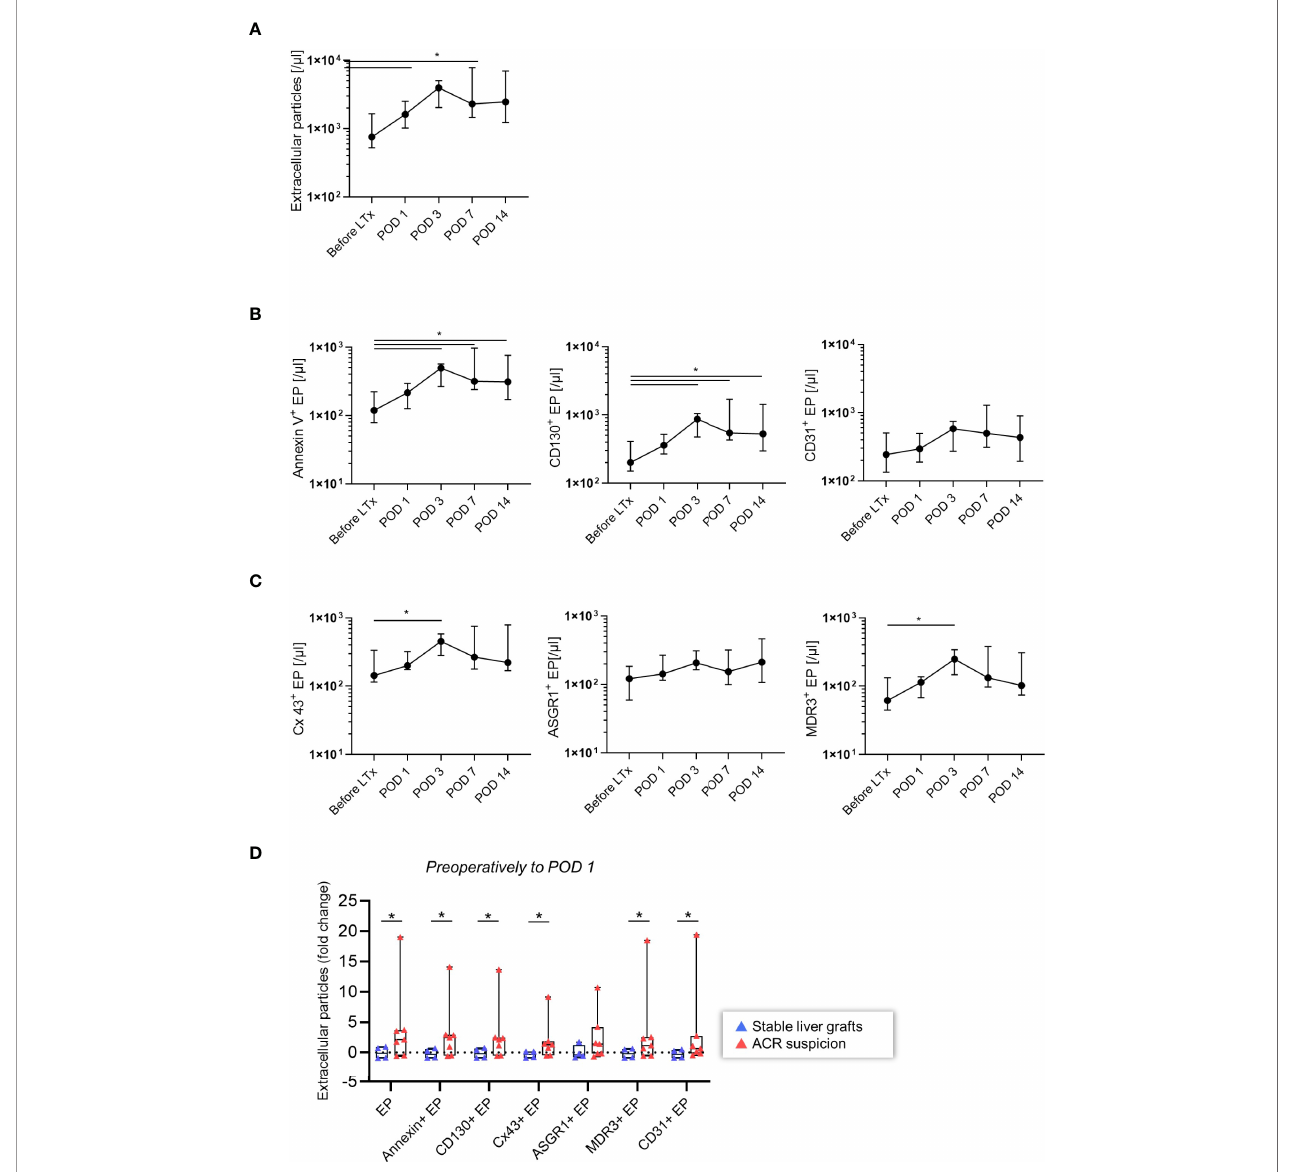
FIGURE 2 | Time course of EP after LT (n = 11). (A) Total EP (/µl) (B) AnnV + , CD130 + , CD31 + EP (/µl) (C) Cx43 + , ASGR1 + , MDR3 + EP (/µl) were stained and analyzed. The Wilcoxon matched-pairs signed ranked test was used. The plots are indicated by the median, and all error bars indicate the interquartile range (IQR). A single asterisk indicates signi fi cance at p < 0.05 (D) Patients at risk for acute rejection. EP dynamics from preoperative state to POD 1 of the total, AnnV + , CD130 + , Cx43 + , ASGR1 + , MDR3 + , CD31 + EP (/µl) and their fold change were analyzed. Absolute EP were non-normally distributed; the two-tailed Mann-Whitney U test was used. The plots are indicated by the mean, and all error bars indicate the